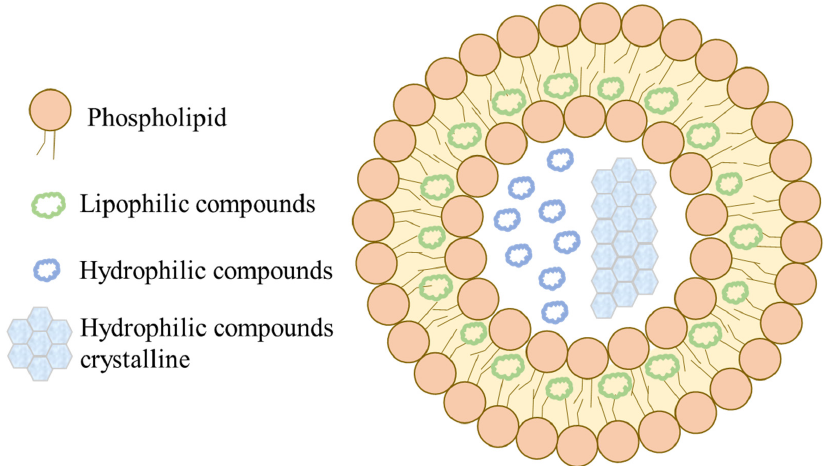
Figure 14. Schematic of the hydrophilic and lipophilic compounds within a liposome. The right indicates that the hydrophilic compounds in the core may undergo crystallization and precipitation.